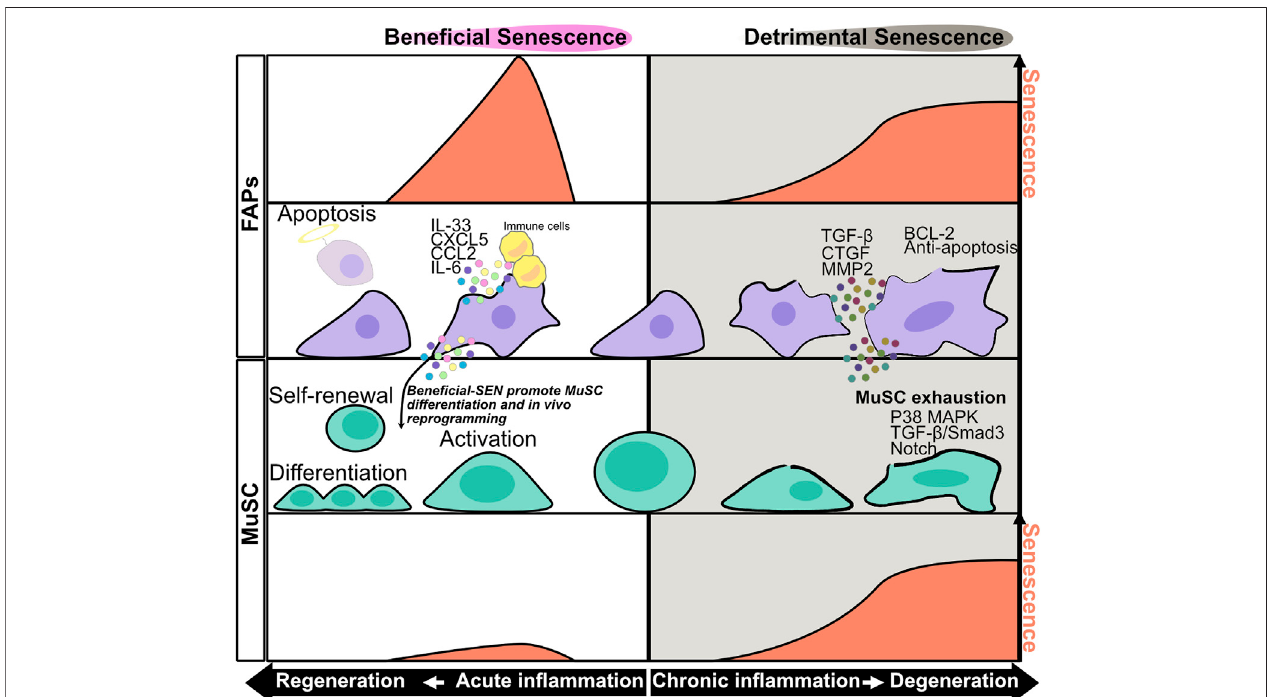
FIGURE 1 | Senescence in muscle stem cells and fi bro/adipogenic progenitors during acute and chronic in fl ammation. During acute in fl ammation leading to regeneration, the level of senescence in fi bro/adipogenic progenitors (FAPs) transiently increases at the early phase of acute in fl ammation and decreases as the cell approaches regeneration. SASP factors produced during acute in fl ammation promote immune cell recruitment and muscle stem cell (MuSC) activation. IL-6 has the potential to promote in vivo reprogramming of MuSCs. The expression level of senescence decreases after clearance of senescent FAPs by immune cells. During chronicin fl ammationleadingtodegenerationphase,thelevelsofsenescenceinFAPsandMuSCsgraduallyincreaseasthecellapproachesdegeneration.SASPfactors produced during chronic in fl ammation, especially TGF- β , promote MuSC senescence and exhaustion, resulting in impairment of muscle regeneration impairment. Chronically senescent FAPs have an anti-apoptotic phenotype, and their prolonged accumulation in muscle results in fi brosis.